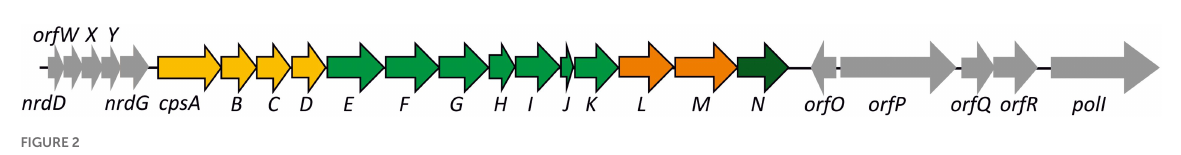
FIGURE 2 Organization of the cps locus of S. anginosus . Arrows depict genes coding for: transferases (green), regulatory proteins (yellow), polymerase and flippase (orange), mutase (dark green), other genes are in grey. Details in the